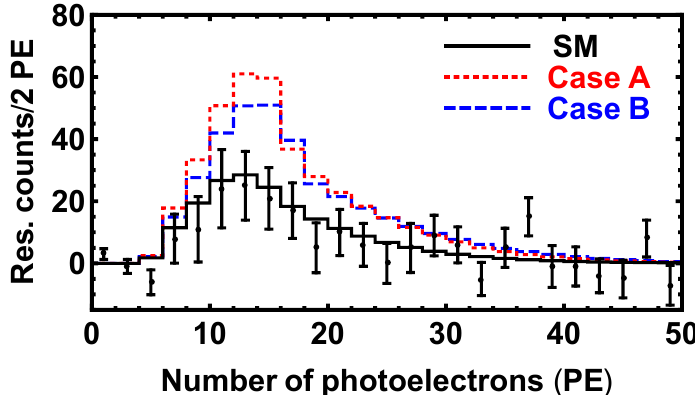
Figure 2 . The expected CE ν NS residual event as a function of the number of photoelectrons at COHERENT. The black solid lines correspond to the SM case, and the red dotted (blue dashed) lines correspond to Case A (B) with θ = 0 , m = 10 MeV, m = 100 MeV, and g q χ a ( θ = π/ 2 , m = 100 MeV, m = 200 MeV, and g = 0 . 01 q χ a χ g q